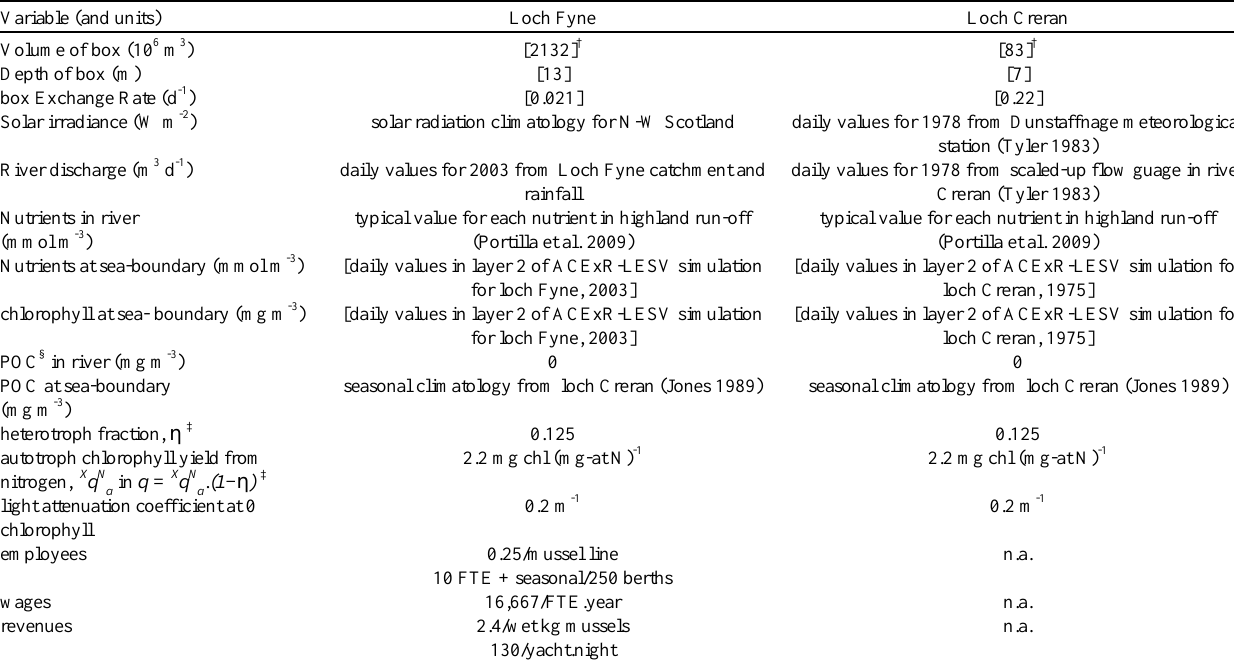
Table 5 . Model boundary conditions and